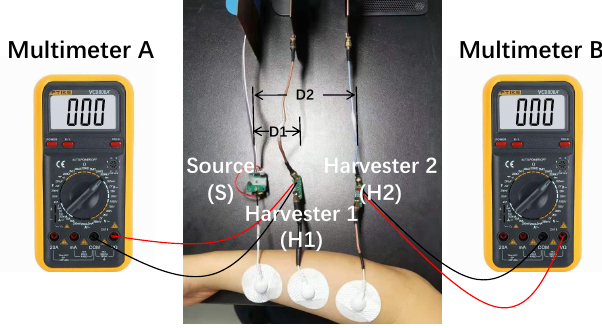
Figure 8. Experiment setup of BC-WPT.